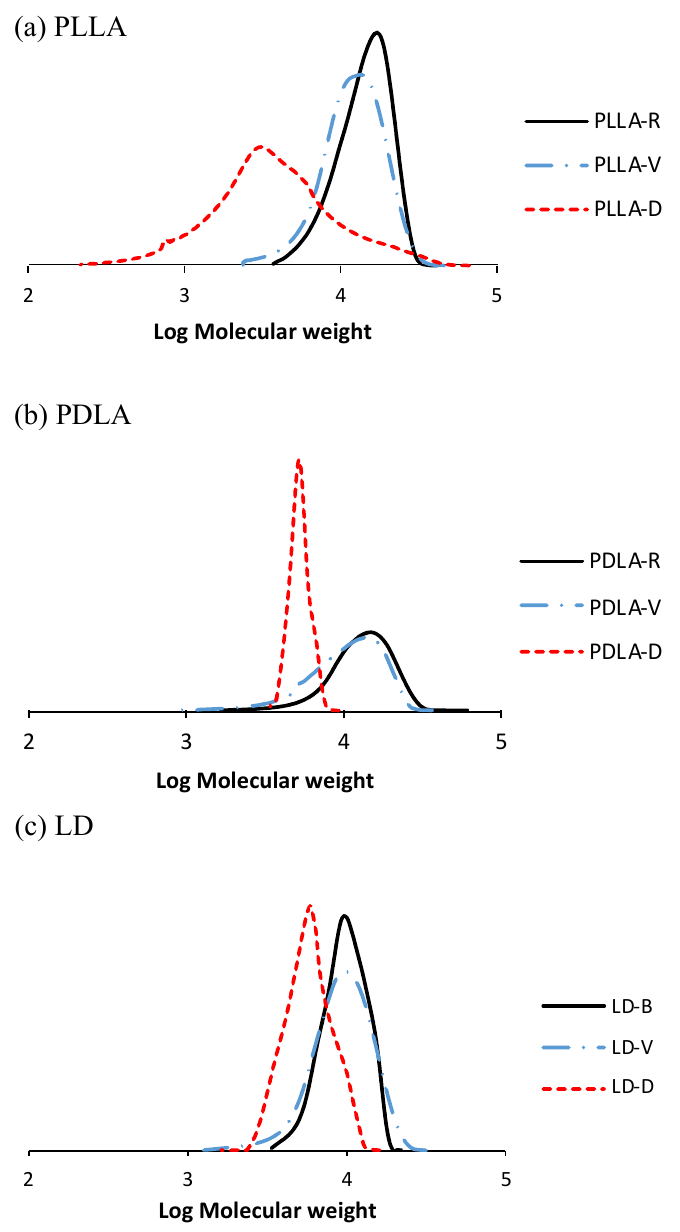
Figure 4. Gel permeation chromatography (GPC) curves of ( a ) PLLA, ( b ) PDLA, and ( c ) LD. The melting behavior of LD-D differed significantly from that of LD-R. During the first heating process, LD-D exhibited a melting peak at 236.4 ◦ C due to the melting of stereocomplex crystals (Figure 6) [27]. No homocrystals were observed. LD-D exhibited high crystallization enthalpy in its cooling curve and only one melting peak during reheat- ing; these observations resulted from the crystallization and melting of the stereocomplex crystals (Figure 7). The melting peak and melting enthalpy values of LD-D were 213.0 ◦ C and 78.8 J/g, respectively (Figure 8). Homocrystallization did not occur in LD-D. Homocrystals were observed in PLLA-R, PDLA-R, PLLA-V, PDLA-V, PLLA-D, PDLA- D, LD-R, and LD-V during the first heating, cooling, and reheating processes. Compared with the thermal behaviors of the received PLLA-R, PDLA-R, and as-blended LD-R samples, no significant differences were observed in the corresponding behaviors of the PLLA-V, PDLA-V, and LD-V samples stored in vacuum-sealed bags. In contrast, the cooling and reheating curves indicated that the samples stored in the vacuum-free desiccator